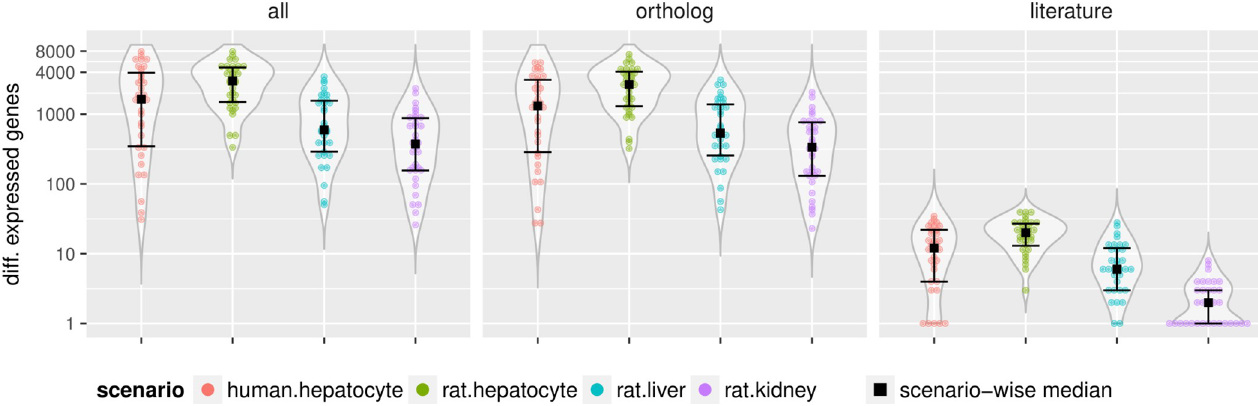
Fig 1. Summary of differential expression analysis. Distribution of the number of differentially expressed genes is depicted with violin-plots by model systems, with each dot representing the number of genes modulated by the high dose treatment with a single compound. The median and interquartile range of each distribution is depicted by black squares and black bars, respectively. On the same plot, we illustrate the distribution of the full set (all), the filtered set with unique human-rat orthologs (ortholog) and the subset found in the corresponding organ-specific literature-derived genes (literature).